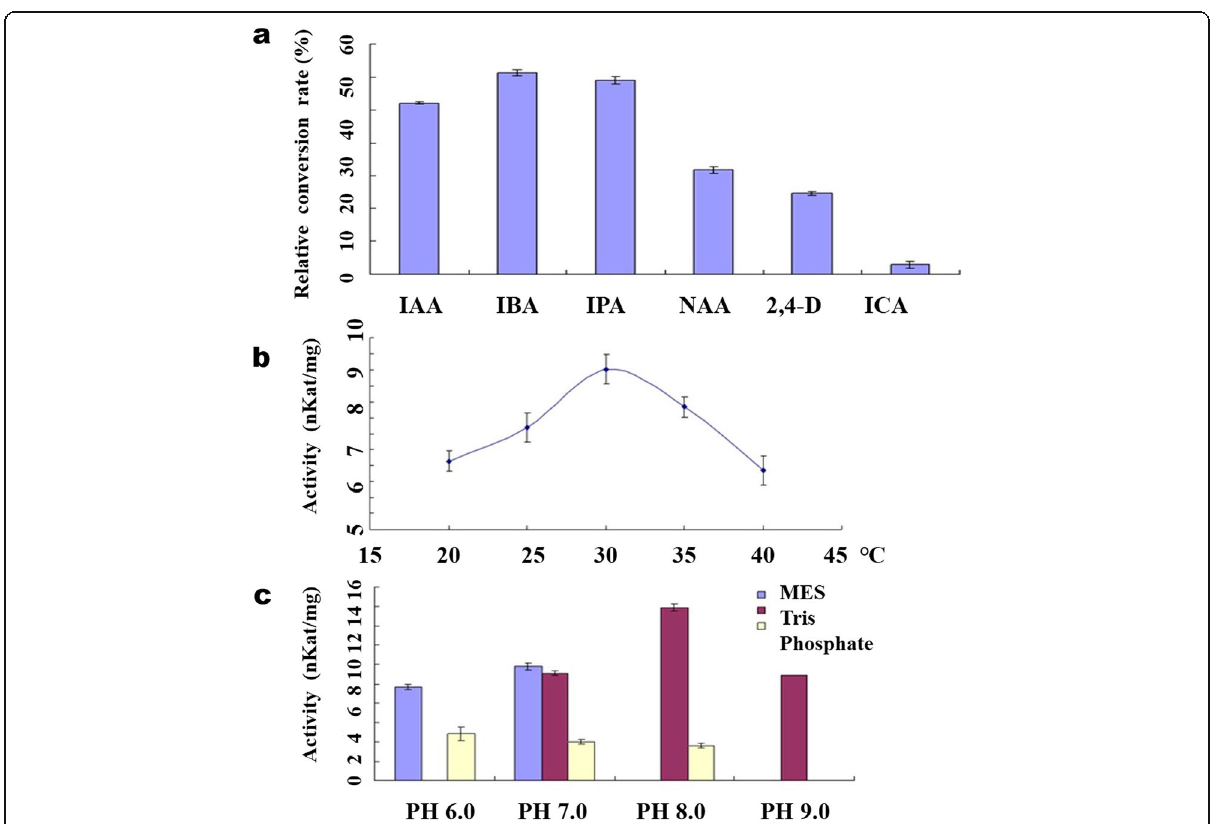
Fig. 4 Biochemical characterization of OsIAGT1. a Relative activity of OsIAGT1 toward auxins and related substrates. b The effect of temperature on the activity of recombinant OsIAGT1 towards IAA (in 50 mM Tris.HCl). c The effect of different recombination of buffer and pH on the activity of recombinant OsIAGT1 towards IAA (at 30 ° С ). Values are means ±SD ( n ≥